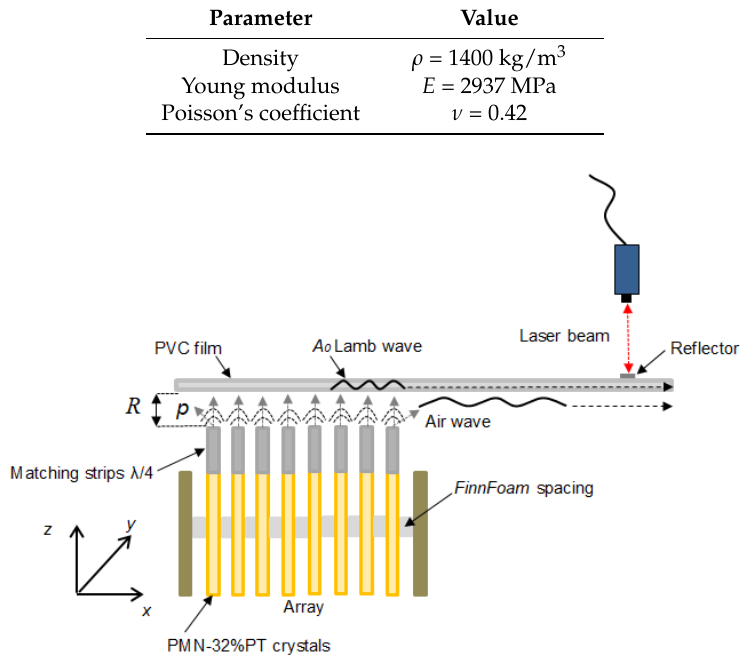
Figure 2. Excitation principle of ultrasonic guided wave by an air-coupled ultrasonic array.